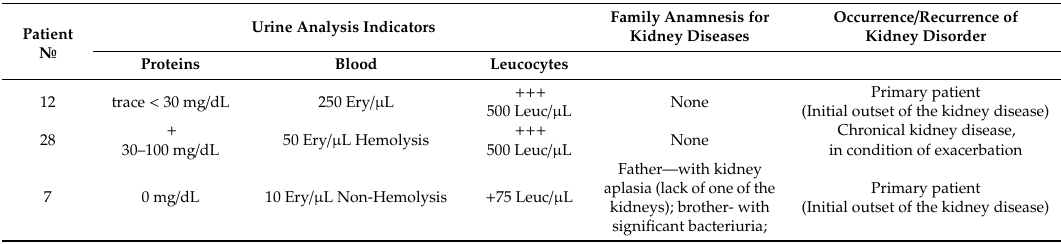
Table 1. Descriptive analysis of anamnestic data and para-clinical urine indicators for all 28 children with pyelonephritis.